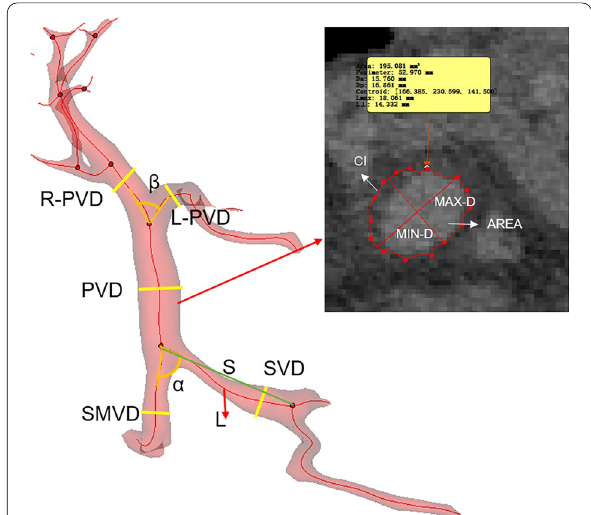
Fig. 1 Illustration of the method of measurement of morphological features. PVD, portal vein diameter; L-PVD, left portal vein diameter; R-PVD, right portal vein diameter; SMVD, superior mesenteric vein diameter; SVD, splenic vein diameter; MAX-D, maximum diameter at the PV cross section; MIN-D, minimum diameter at the PV cross section; AREA, the area of PV cross section; CI, Circumference of PV cross section; α, the angle of SMV and SV; β, the angle of LPV and RPV; S, the linear distance from the starting point of the SV to hilus lienis; L, the length of center line of the SV from the starting point of the SV to hilus